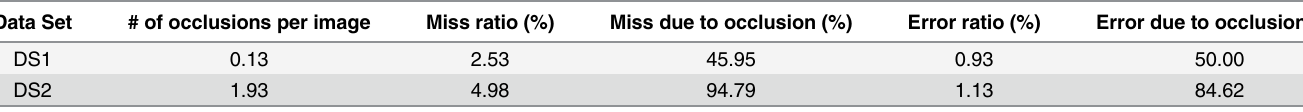
Table 2. Evaluation of detection performance.